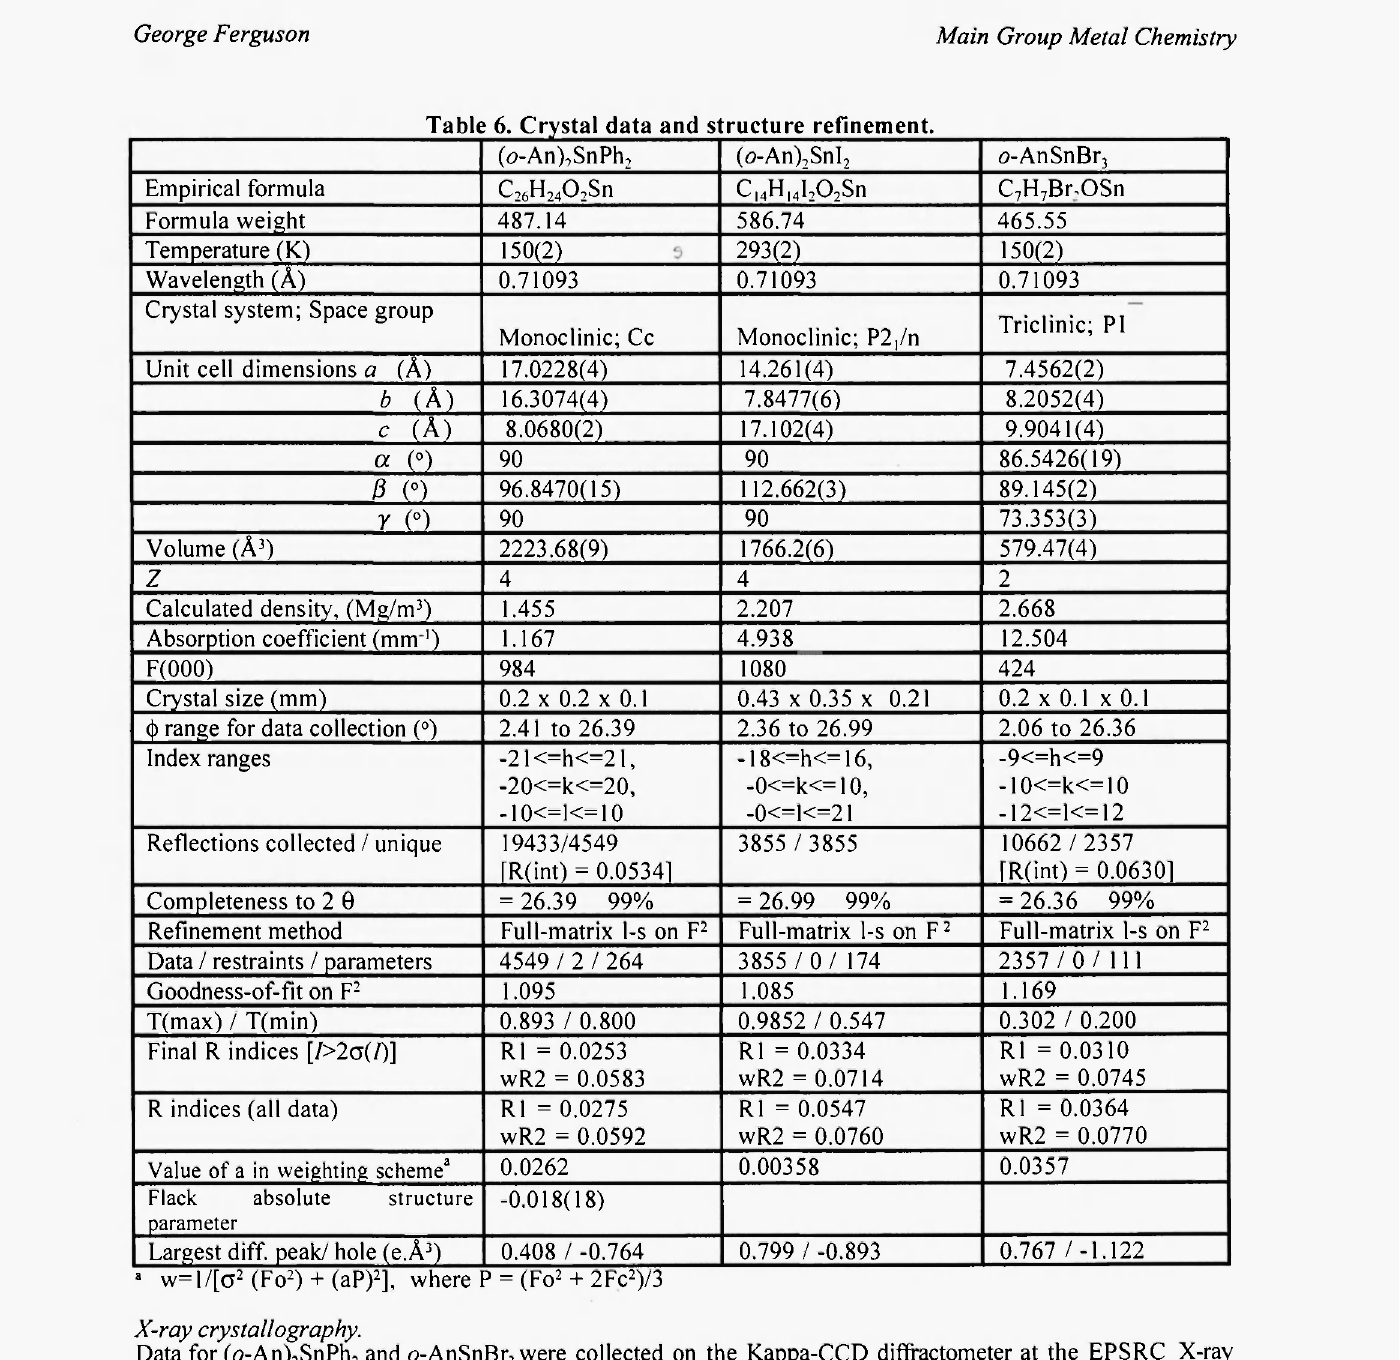
Table 6. Crystal data and structure